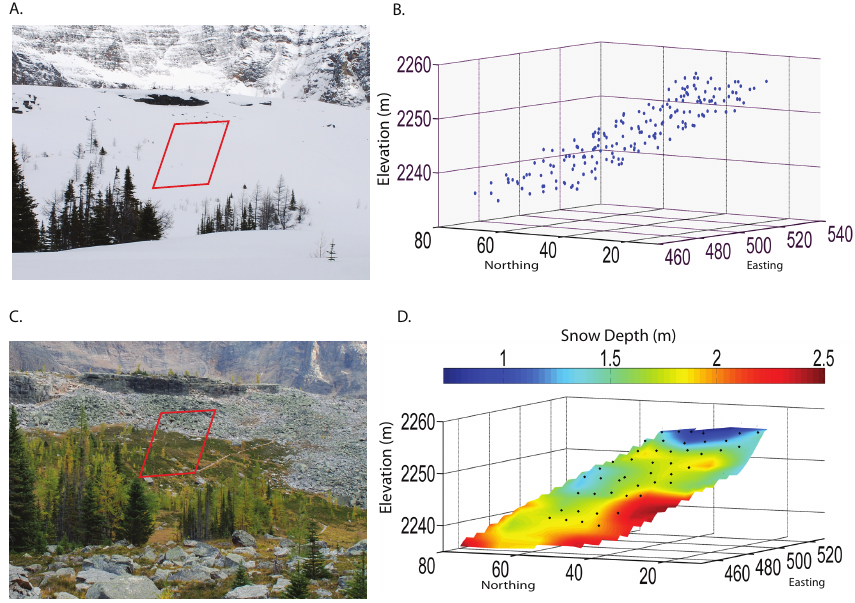
Fig. 3. Validation slope (A) snow covered (18 April 2009), (B) distribution of laser points (April), (C) snow free (30 September 2009), (D) laser snow depth (black dots show locations of manual snow depth measurements).